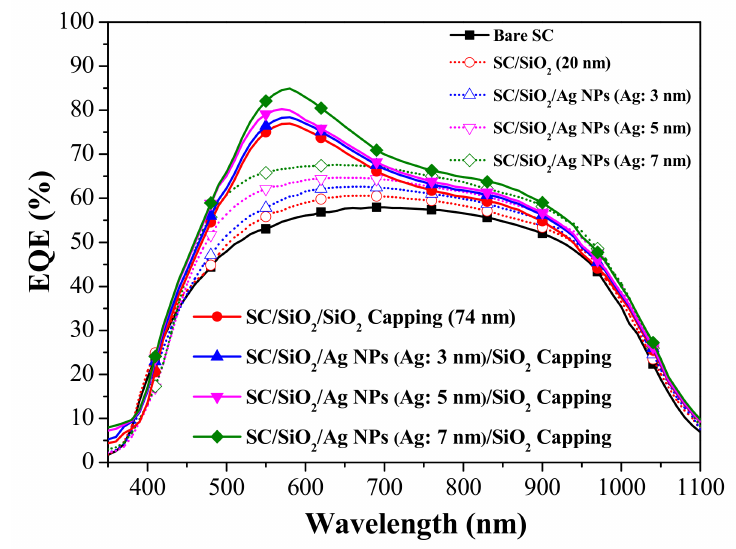
Figure 5. EQE responses of all evaluated solar